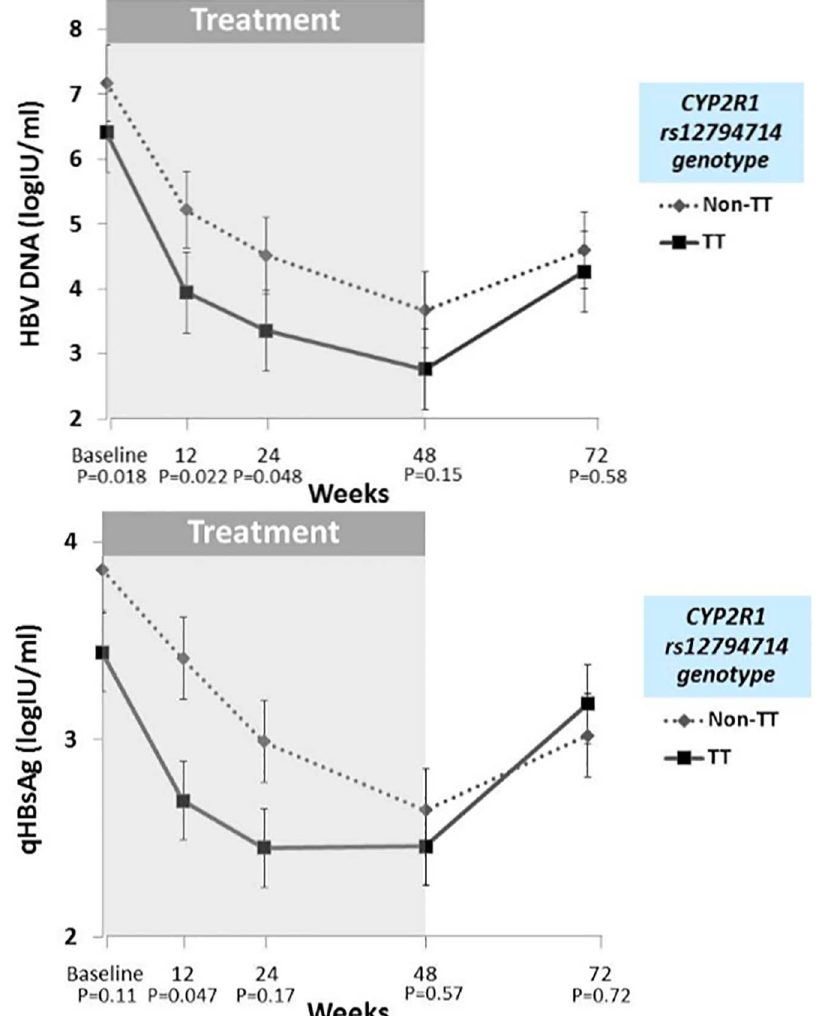
Fig 1. Mean HBV DNA and qHBsAg during PegIFN therapy in patients stratified by CYP2R1 rs12794714 TT and non-TT